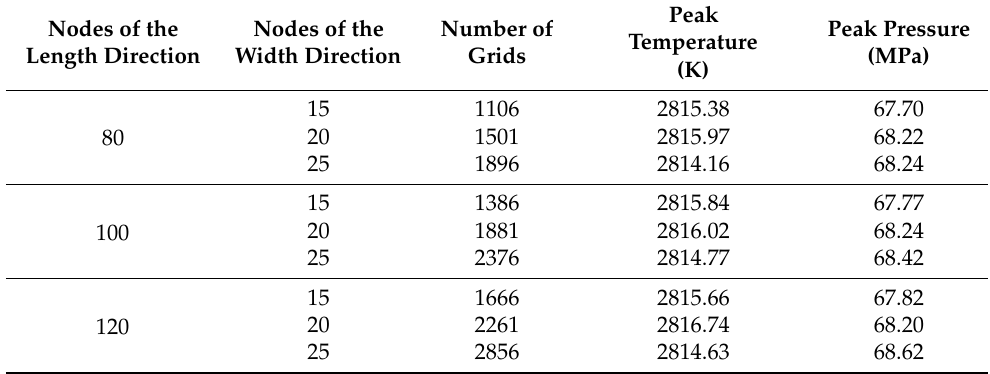
Table 1. The mesh information and the calculation results. Nodes of the Length